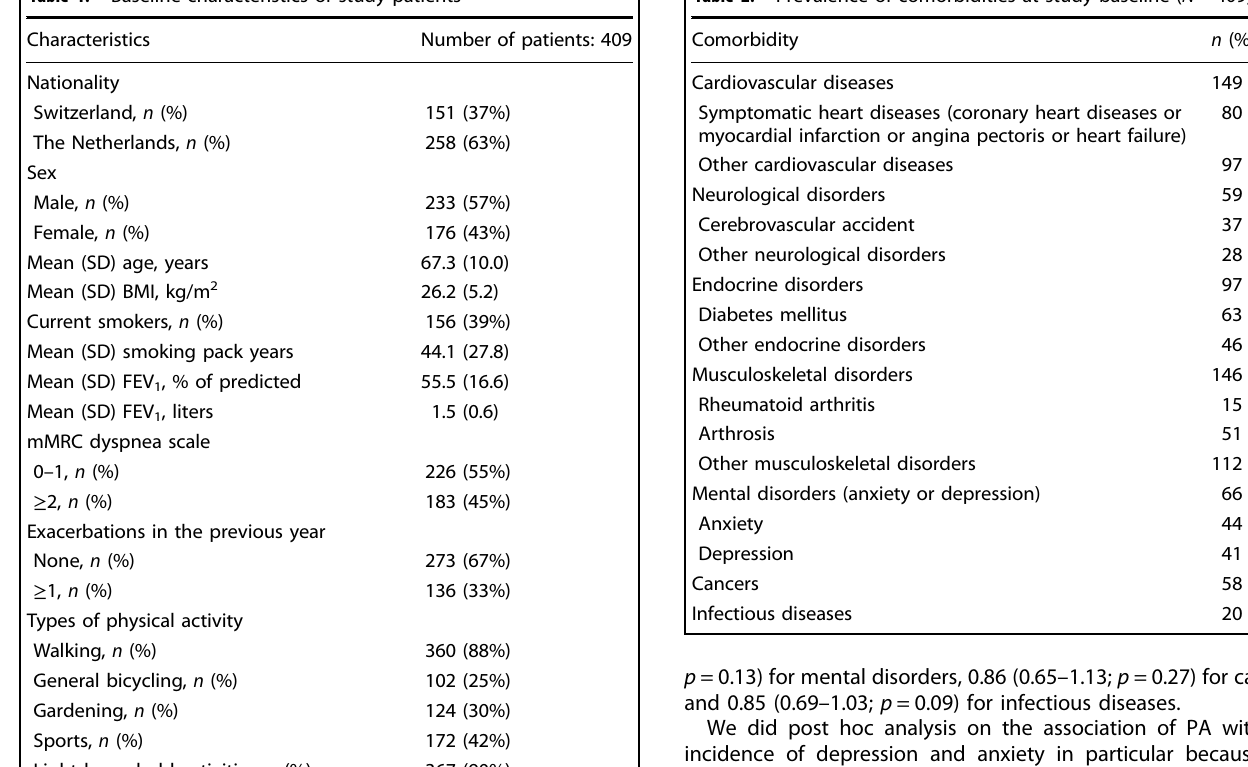
Table 2. Prevalence of comorbidities at study baseline ( N =